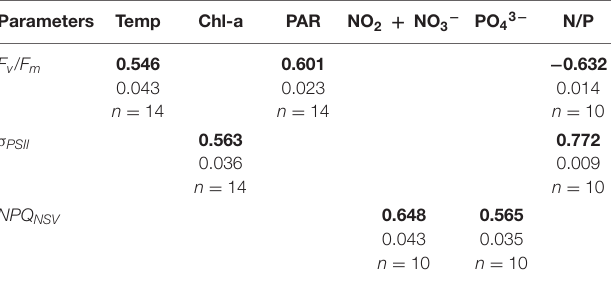
TABLE 6 | Spearman correlation coefficients for correlations between photophysiological parameters and environmental variables. Parameters